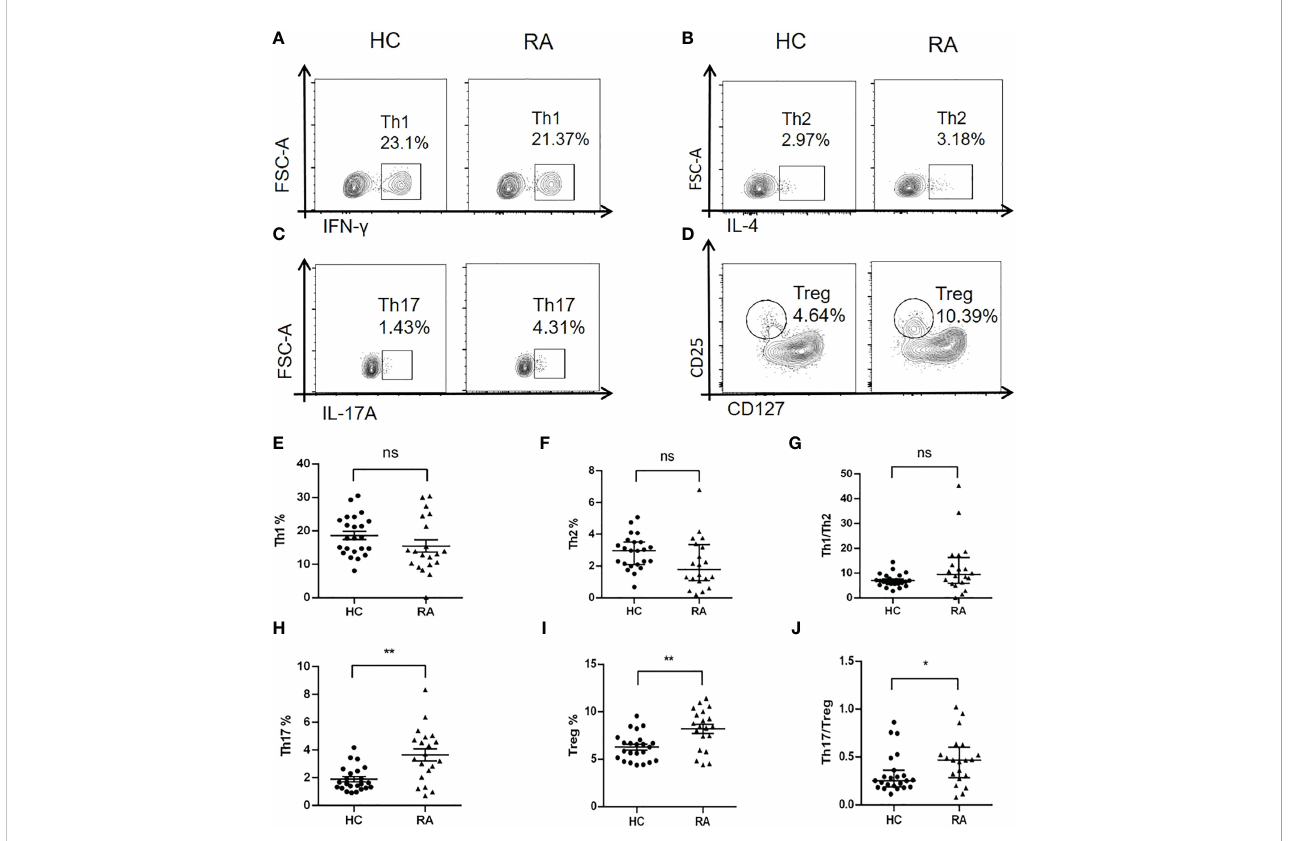
FIGURE 4 Multiparameter fl ow cytometry analysis of peripheral CD4 + T cell subtypes in RA patients and health controls. (A, E) Representative fl ow-cytometric histogram and quantitative analysis of the Th1 subset (CD4 + IFN- g + ). (B, F) Representative fl ow-cytometric histogram and quantitative analysis of the Th2 subset (CD4 + IL-4 + ). (C, H) Representative fl ow-cytometric histogram and quantitative analysis of the Th17 subset (CD4 + IL-17A + ). (D, I) Representative fl ow-cytometric histogram and quantitative analysis of the Treg subset (CD4 + CD25 + CD127 - ). (G) The ratio of Th1/Th2. (J) The ratio of Th17/Treg. Each dot represents one individual and data are the mean ± SD. *P < 0.05, **P < 0.01 . ns, not signi fi cant.